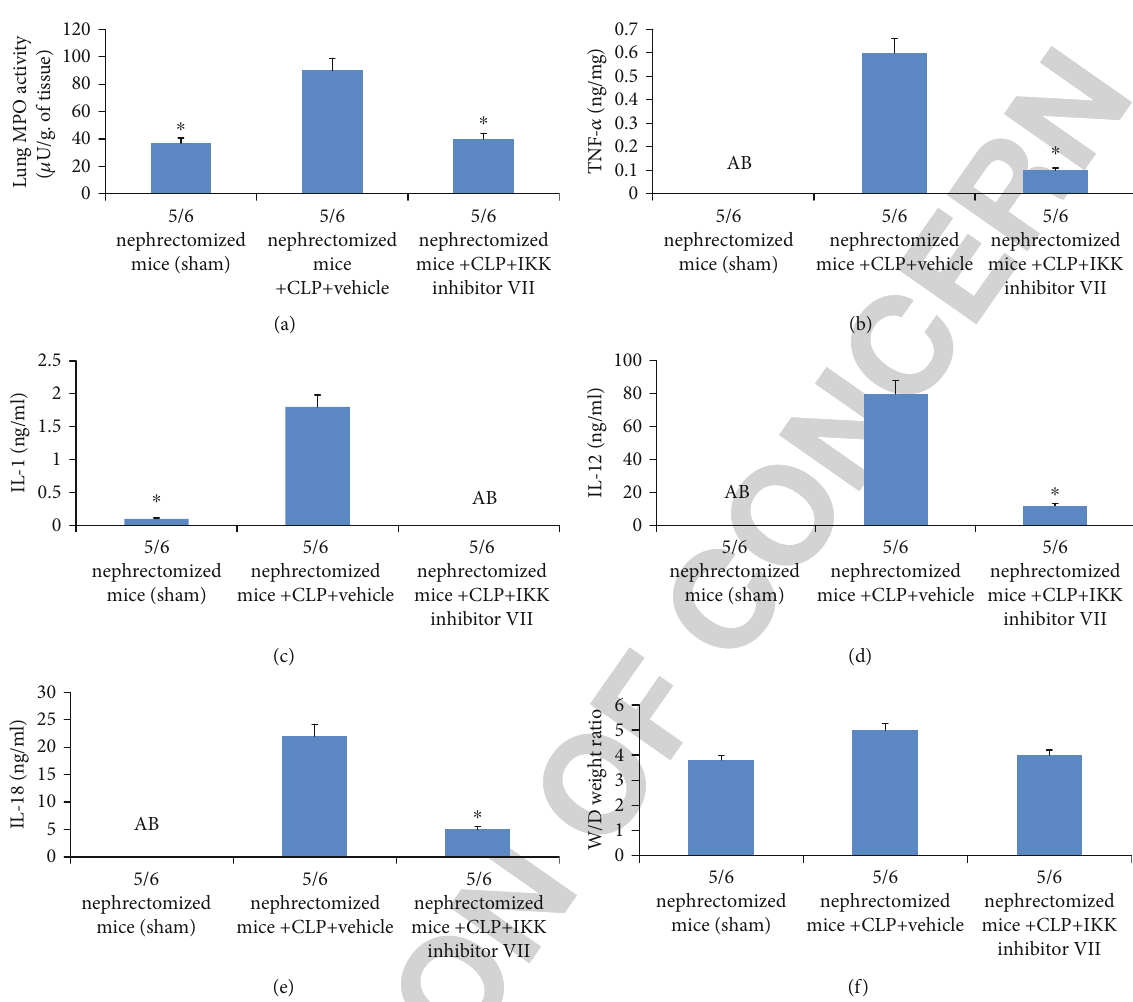
Figure 9: Blockade of IKK provides attenuation in systemic and lung in fl ammatory response mediated by CLP in 5/6 nephrectomized mice. The 5/6 nephrectomized mice were subjected to CLP or sham surgery. After 1-hour CLP, 5/6 nephrectomized mice were exposed to either IKK inhibitor VII (1 mg/kg I.V.) or DMSO 9 (2%) (vehicle). The lung in fl ammatory and systemic markers were evaluated after 24 hours. (a) MPO activity was assessed in lung tissues, (b) levels of TNF- α in plasma, (c) levels of IL-1 in plasma, (d) levels of IL-12 in plasma, (e) levels of IL-18 in plasma, and (f) results of wet to dry (W/D) ratio of lungs. All the results are mean ± SEM . AB: absent; ∗ P < 0 : 05 compared to 5/6 nephrectomized, CLP, and vehicle-treated